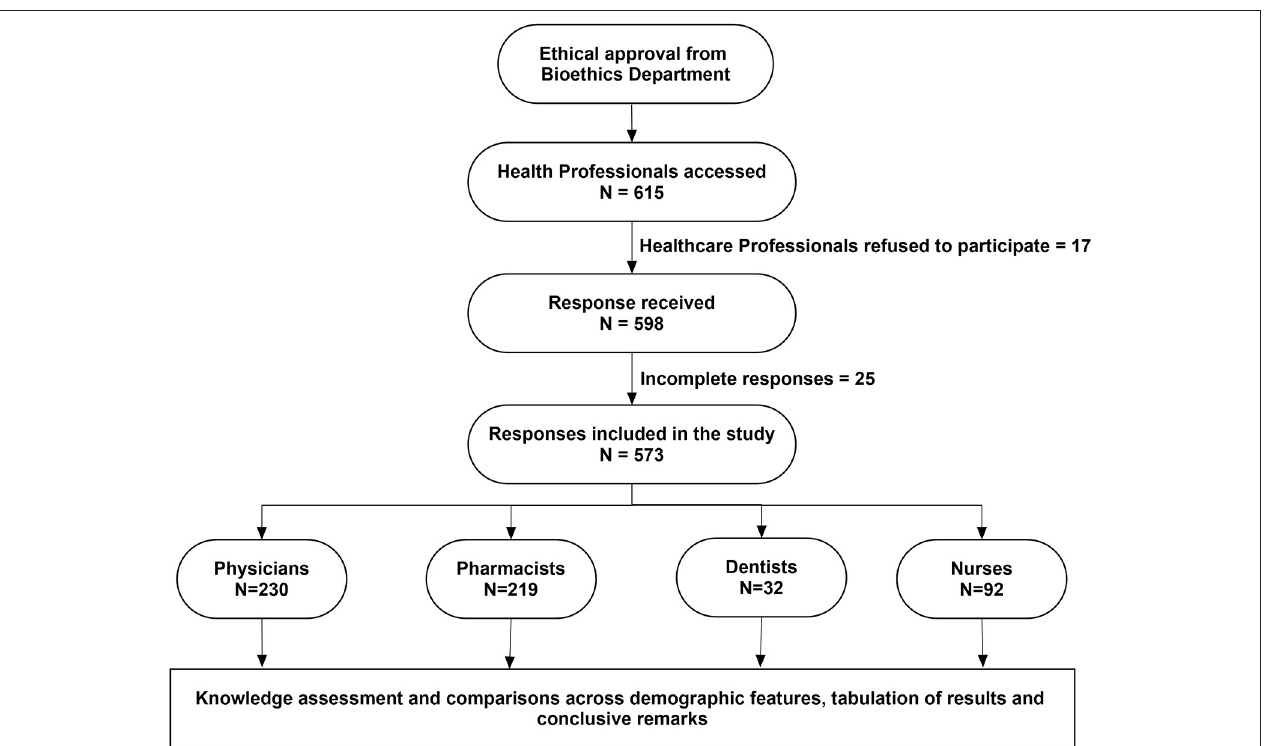
FIGURE 1 | Study flow